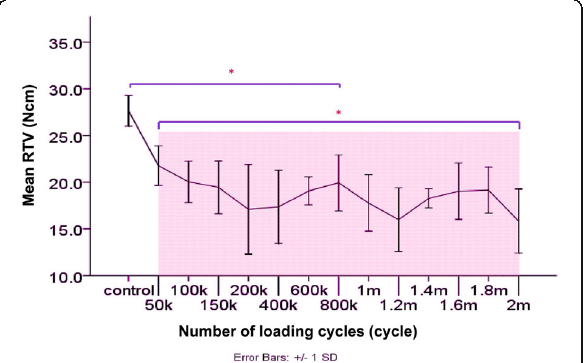
Fig. 8 Change in RTVs according to the numbers of mechanical loading